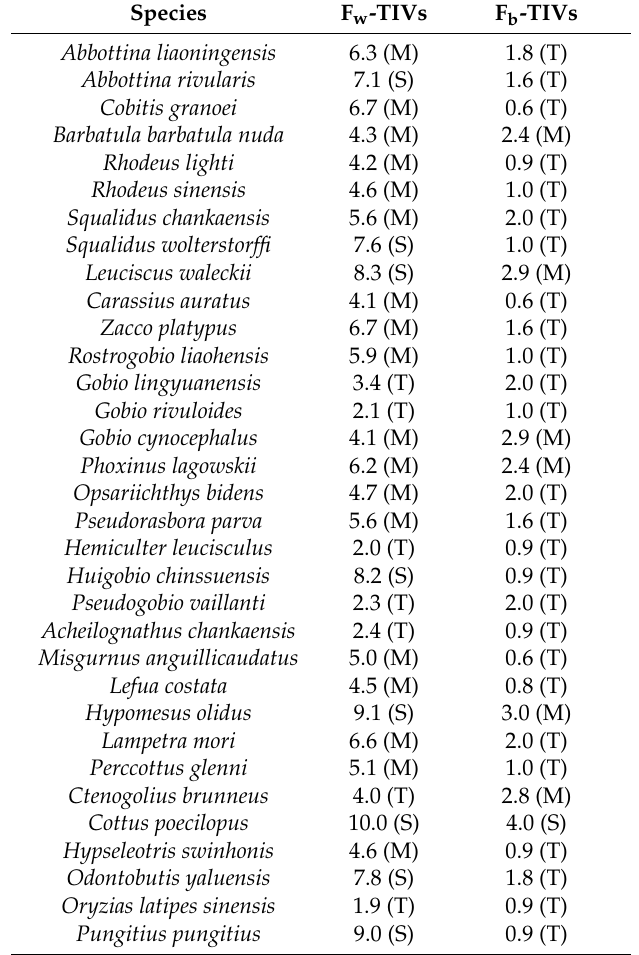
Table A2. Summary of F w -TIVs and F b -TIVs for fish species and tolerance